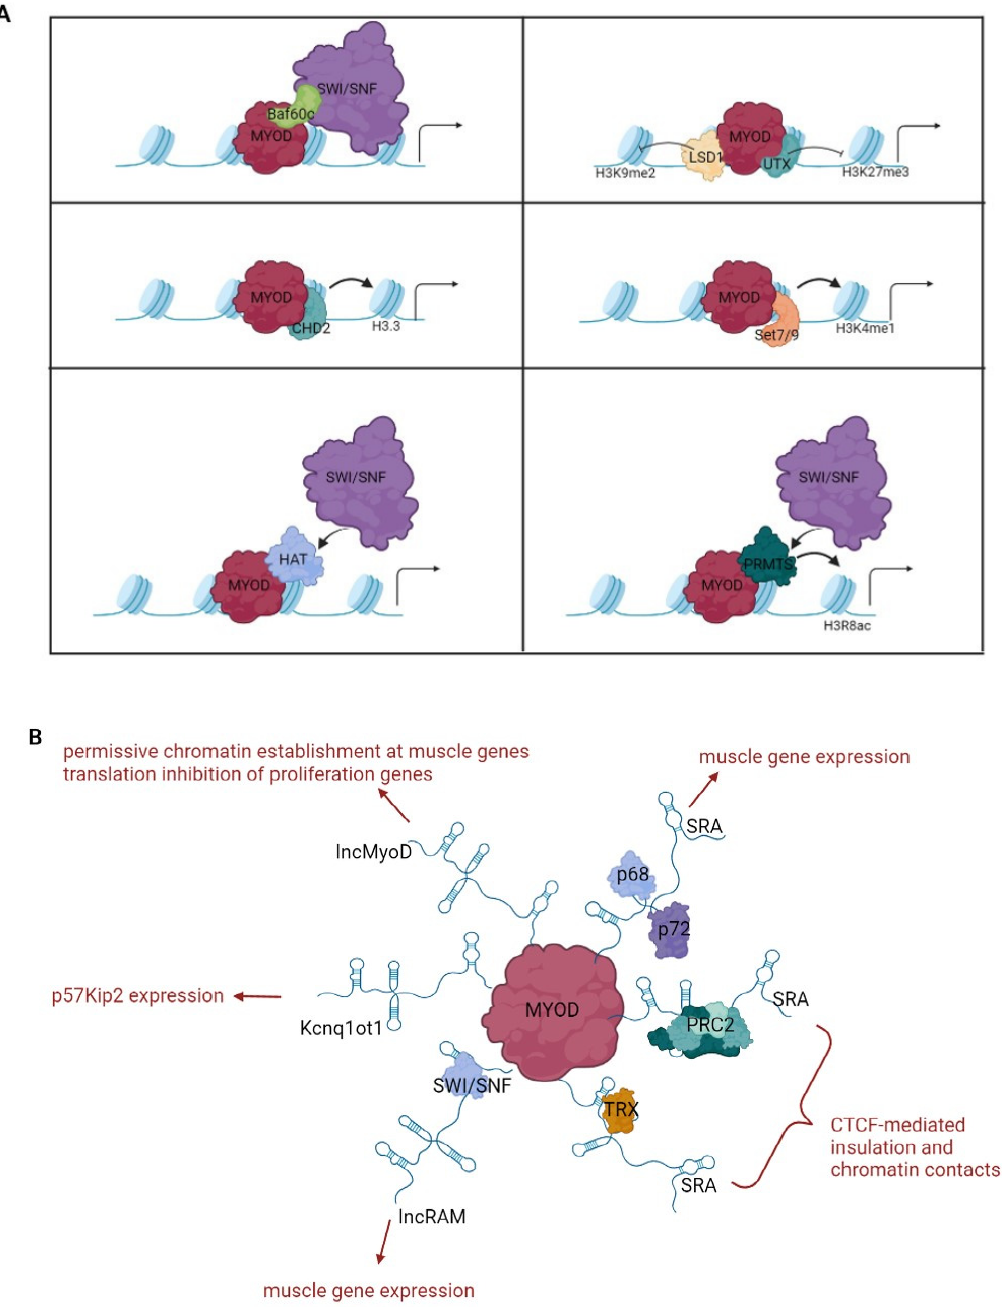
Figure 2. Chromatin regulation by MyoD. The drawings outline the best characterized chromatin modifying complexes ( A ) and long noncoding RNAs ( B ) exploited by MyoD for chromatin repro-